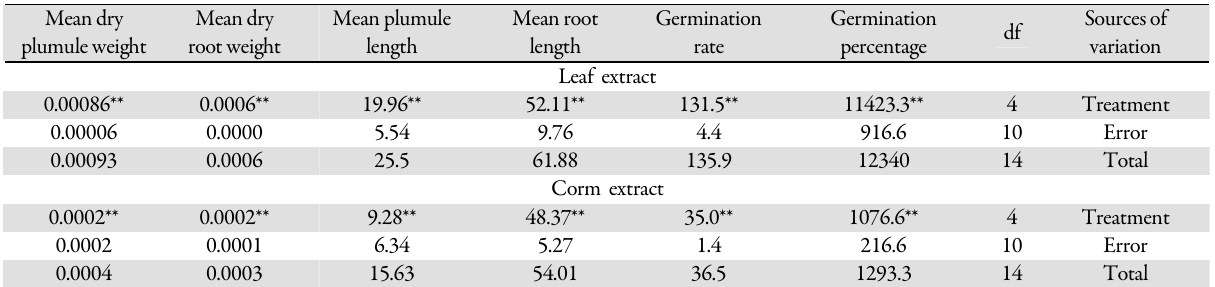
Tab. 1. Analysis of variance (sum of square) for the effects of different levels of saffron corm and leaf extract on germination and seedling growth criteria of